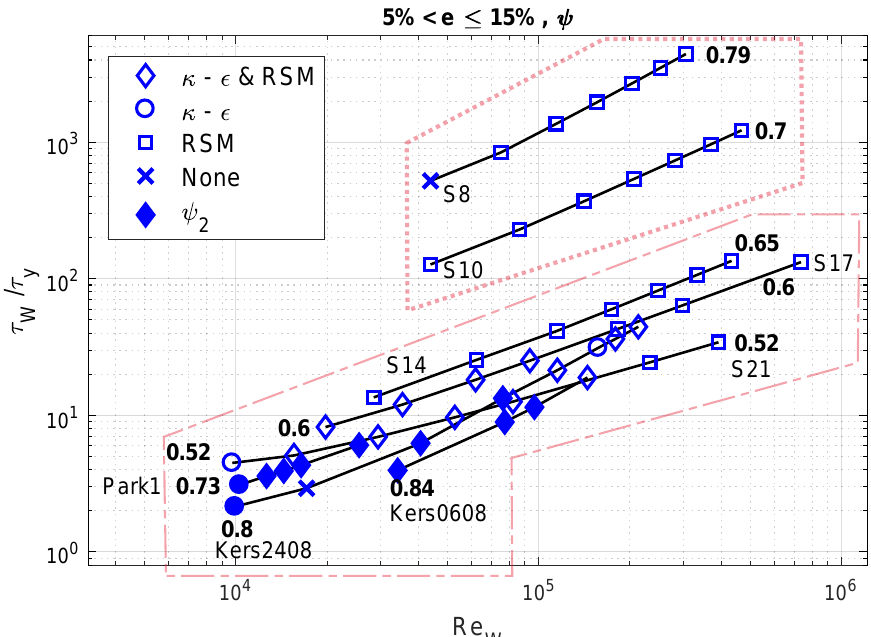
Figure 16. Performance of the standard RANS models combined with ψ 1 to achieve an error 5% < e ≤